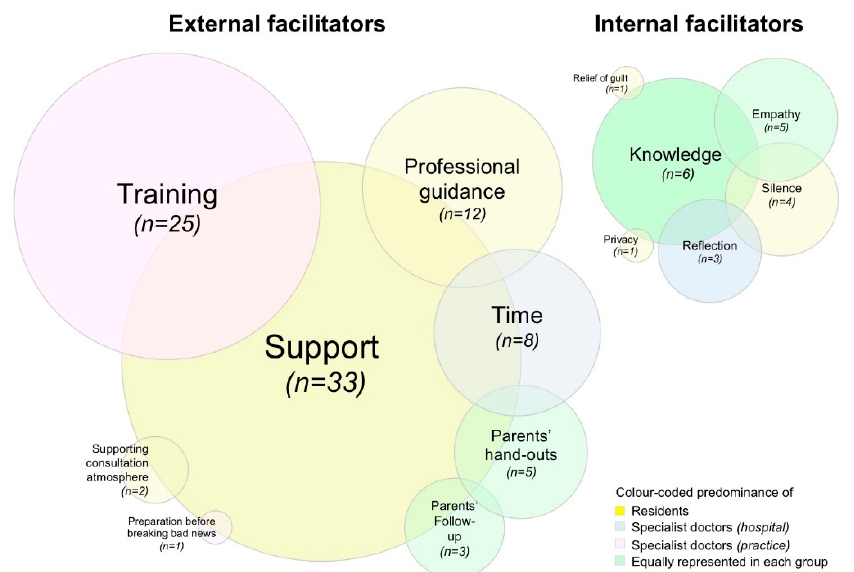
Figure 5. Graphical theme cloud illustrating obstetricians’ external and internal facilitators for breaking news of fetal death to affected parents. The size of the circles directly correlates with the number of positive replies by obstetricians. The color of the circles represents the respective professional group, which predominantly quoted this element in the open response (i.e., residents; specialist doctors in hospital and practice, respectively; departmental heads). Table 2. Sample narratives by obstetricians expressing their spectrum of external facilitators when delivering news of fetal